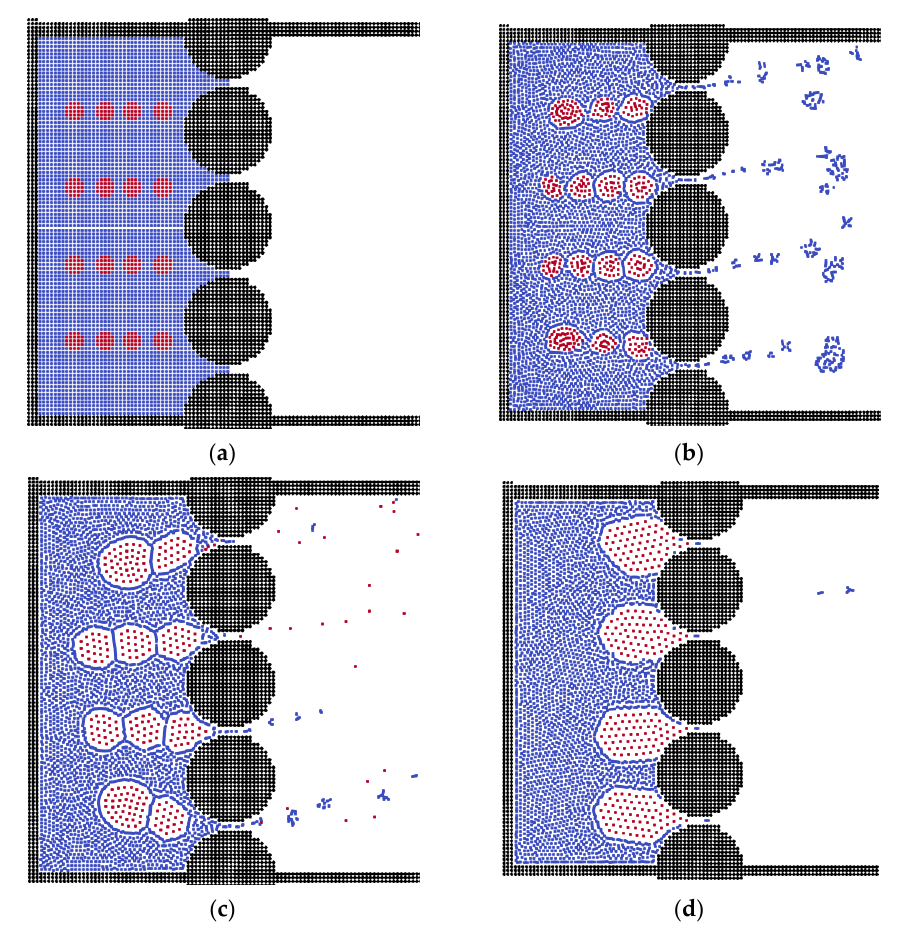
7 of 15 Figure 2. The separation processes during different time steps. ( a ) Step = 5, ( b ) Step = 20, ( c ) Step = 100, ( d ) Step = 200. As can be seen in Figure 2, after 30 steps, the oil clusters accumulate on the surface of the membrane due to the surface tension. In the flat membrane system, the oil droplets can pass through the membrane easily, and the oil particles, which cannot be further ex- cluded, adsorb on the corner of the box. Therefore, the flat membrane can separate small- size oil droplets, which agrees well with previous work [53]. When the droplets gather into bigger oil clusters, the membrane becomes blocked, but this shows a good separation boundary within the waste water domain [54]; afterwards, the oil clusters move and ad- sorb on the corner of the system due to the lower surface energy. 3.2. The Effects of Membrane Structures Different polymeric membranes have been used for oil–water separation [55], but in